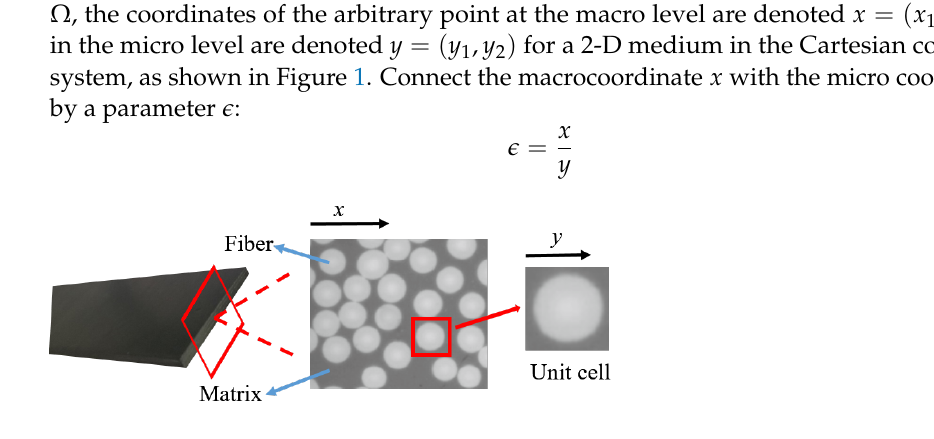
Figure 1. Selection of